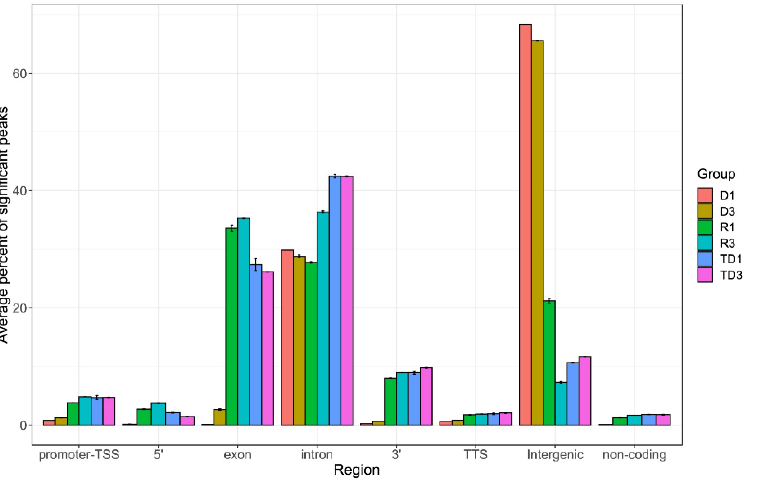
Figure 6. Peak annotation on entire genome. After obtaining peak sets, peak annotation was performed to associate with nearby genes and genomic features. A false discovery rate (FDR) cutoff of 0.001 was used for identifying significant peaks. Peak annotation was performed using Homer software and the annotate_peaks function to associate each peak with nearby genes and genomic features. Annotated positions for promoter-TSS, exons, introns, and other features were based on the mm10 transcripts. Enrichment analysis of associated genes was also performed using Enrichr for identifying Gene Ontologies (GOs) and pathways significantly over-represented by associated gene sets. For each sample group (D: DNA bound RNA in sperm; R: free RNA in sperm; TD: DNA bound RNA in testis), we measured the percent of significant peaks that were located in each genomic region. Y-axis shows the average percentage in biological replicates of each sample group. Error bars represent mean ± SD.